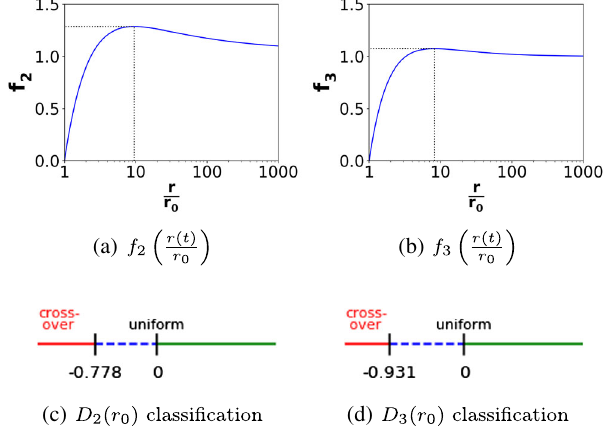
FIG. 5. (a-b.) Plot of the functions f 2 and f 3 against r . Since r 0 > 1 for particles are always moving away from the origin, r r 0 positive times and this ratio goes to infinity as time goes to infinity. Both functions have a similar character with a maximum in the 8 − 10 r 0 range, and they both eventually approach one from above. Dashed lines in the plots indicate the location of the functions ’ maxima. These functions allow us to analytically ð r Þ ¼ classify the distribution by the initial value of D 0 d d ð ρ 0 ð r 0 Þ − 1 Þ as is done in (c-d). Specifically, crossover may ¯ ρ 0 ð r 0 Þ 2 < 0 . For negative values of D occur at some time when dr d dr 0 crossover first occurs at the maximum of f d and the value of D d at which that occurs is given in the schematics of (c,d). For values of D d that are more negative than this value, crossover will occur at some time in some parts of the distribution. For the uniform distribution, D ð r 0 Þ ¼ 0 for all points inside the distribution. The dashed blue line indicates expansion less quickly than the uniform distribution, while the green line indicates more rapid expansion than for the uniform